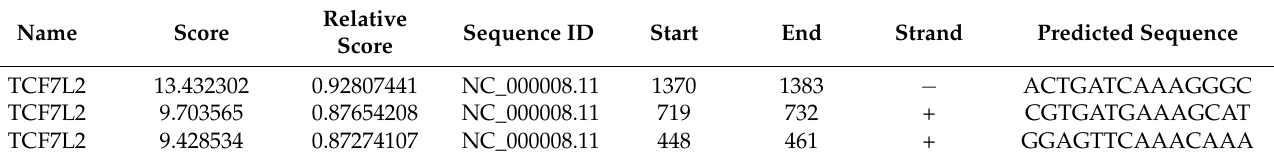
Figure 4. Mechanism of Fg f9 promoting HA expression. ( A ) Effect of different concentrations of rhFGF9 (0–50 µg/mL) on HA secretion in MEPM. ( B , C ) The protein levels of HAS2 in MEPM cells after treatment with BML-284 or DKK-1 were determined by Western blot assay. ( D – F ) The protein levels of HAS2 and TCF7L2 in KO MEPM cells and WT MEPM cells treated with 0, 10, or 20 µg/mL rhFGF9 were determined by Western blot assay. Asterisks indicate a significant difference from the KO MEPM cells.( G ) Elisa analysis of HA expression in WT and KO MEPM with different treatment. ( H ) Schematic diagram of mechanism of this research. The bar graph represents the mean ± SEM. ns: no significance, p ≥ 0.05, ** p < 0.01, *** p < 0.001, **** p < 0.0001. Western blot analysis showed differences of HAS2, β -catenin, and TCF7L2 expression in Wildtype and Fgf9 − / − palate. Table 2. TCF7L2 binding sites in Has2 promoter were predicted by JASPAR. The closer the relative score is to 1 indicating a tighter